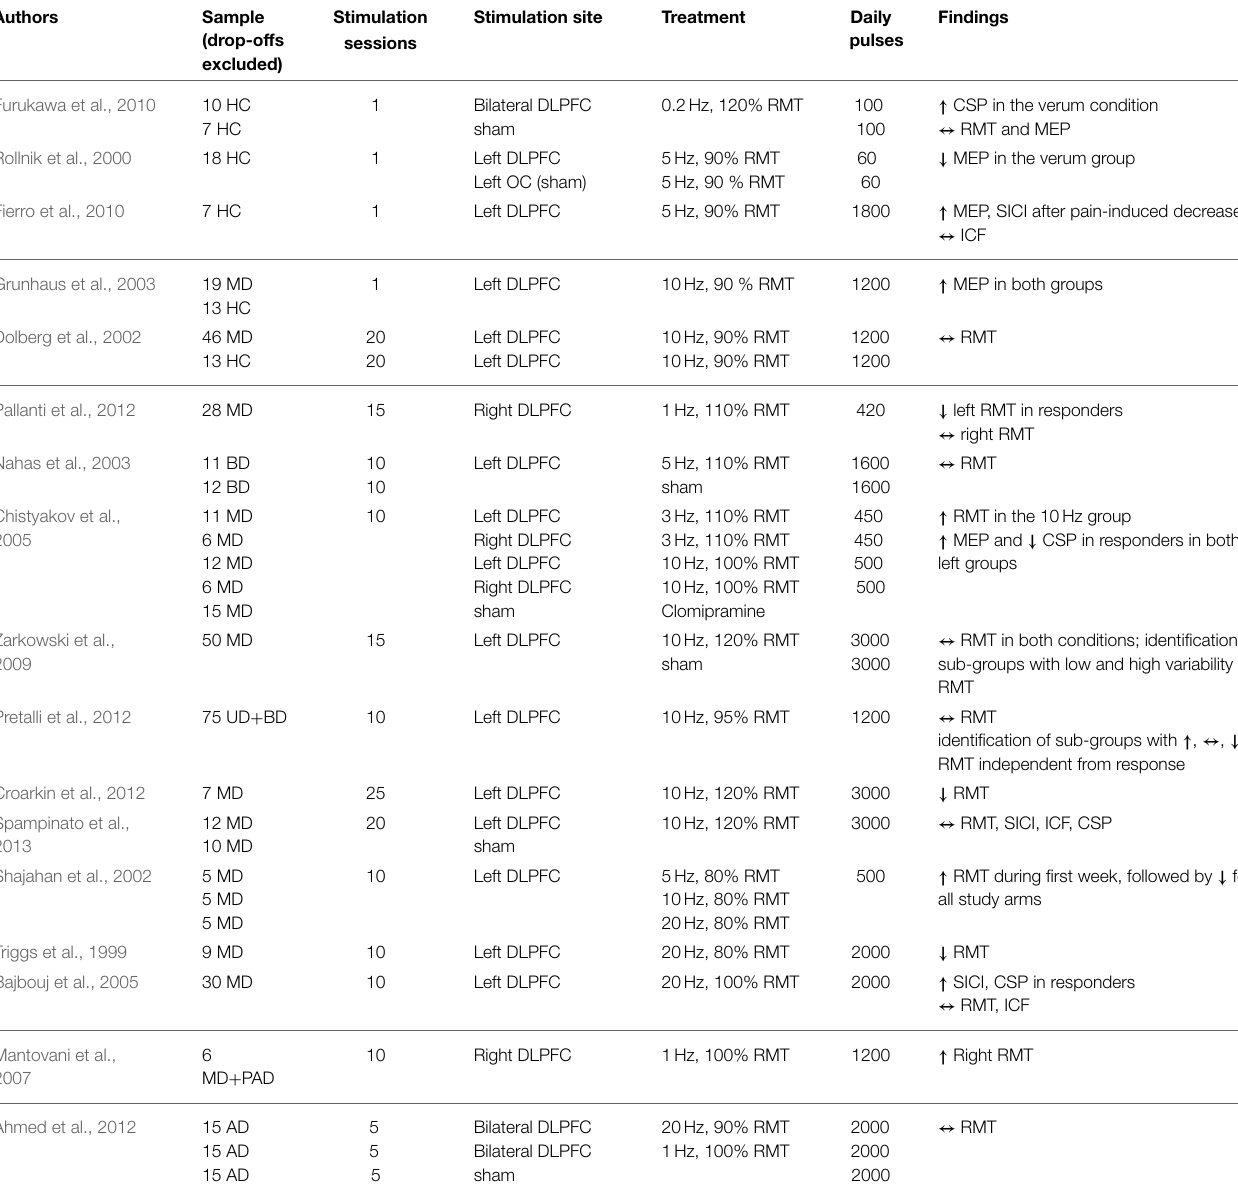
TABLE 2A | Overview of study parameters of prefrontal cortex rTMS studies investigating motor cortex